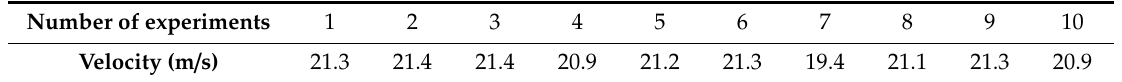
Table 2. Steel projectile initial velocity.